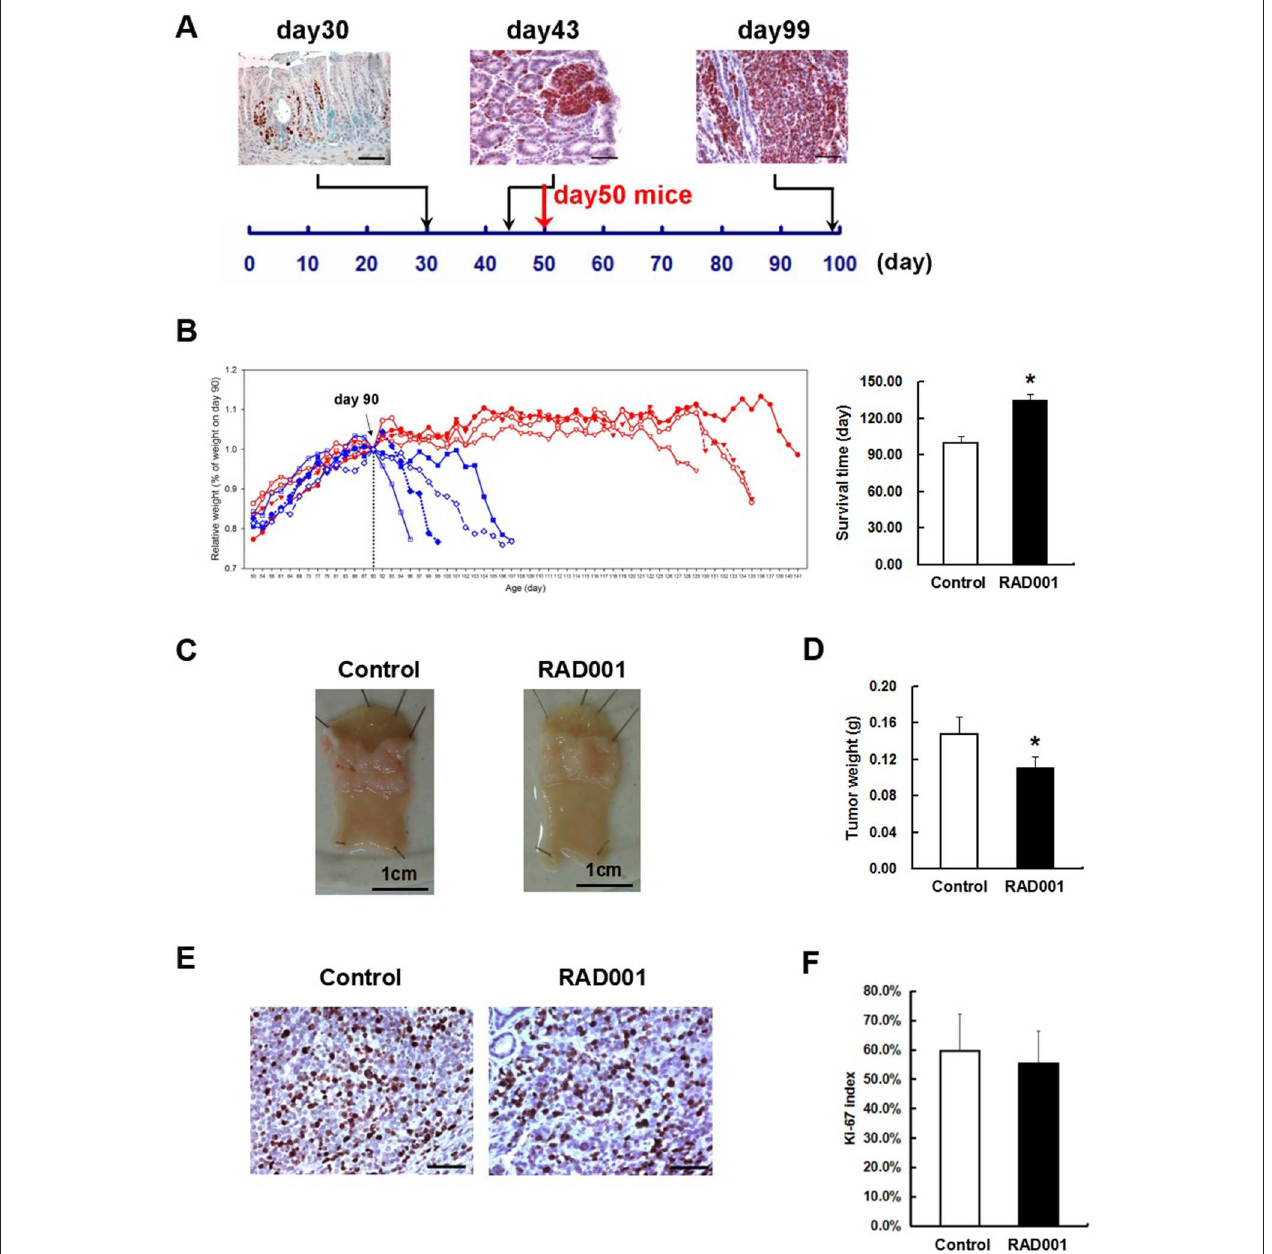
FIGURE 3 | RAD001 treatment prolonged the survival time of the CEA424-SV40 TAg transgenic mice. (A) SV40-TAg staining was applied to stomach sections from mice of different age. In vivo experiment started with mice of day-50, when tumors were well-formed. Scale bars: 50 µ m. (B) Left: weight curves of the CEA424-SV40 TAg transgenic mice. Blue curve: control group; red curve: RAD001 treated group. Right: mean age of the CEA424-SV40 TAg transgenic mice when they lost 20% of the peak weight (* p < 0.0001: RAD001 treated group vs. control group). (C) Macroscopic picture of the stomachs from control mice and RAD001 treated mice after 48 days of treatment with placebo or RAD001. Mean tumor weight of these two groups was shown in (D) (* p < 0.05: RAD001 treated group vs. control group). (E) An example of the Ki67 staining on stomach sections from control mice and RAD001 treated mice. Scale bars: 50 µ m. No significant difference was found for the Ki-67 index in the two groups (F)